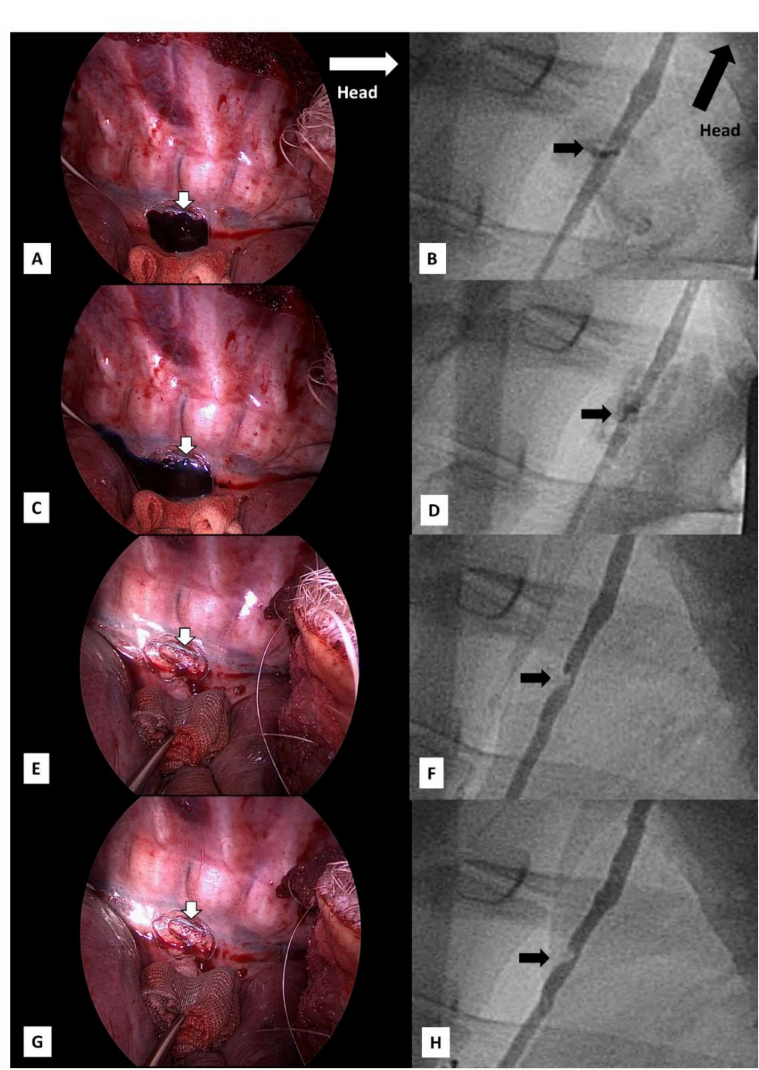
Figure 1. Leakage (arrow) shown by video-assisted ( A ) thoracoscopy and ( B ) lymphangiography immediately after thoracic duct injury by electrocautery, and ( C , D ) it was still evident 5 min after injecting 2 mL of iopamidol and 0.5 mL of indigo carmine into the distal thoracic duct. However, the leakage was healed at ( E , F ) 10 and ( G , H ) 30 min as shown in the surgical field and lymphangiography images. (Group A #4